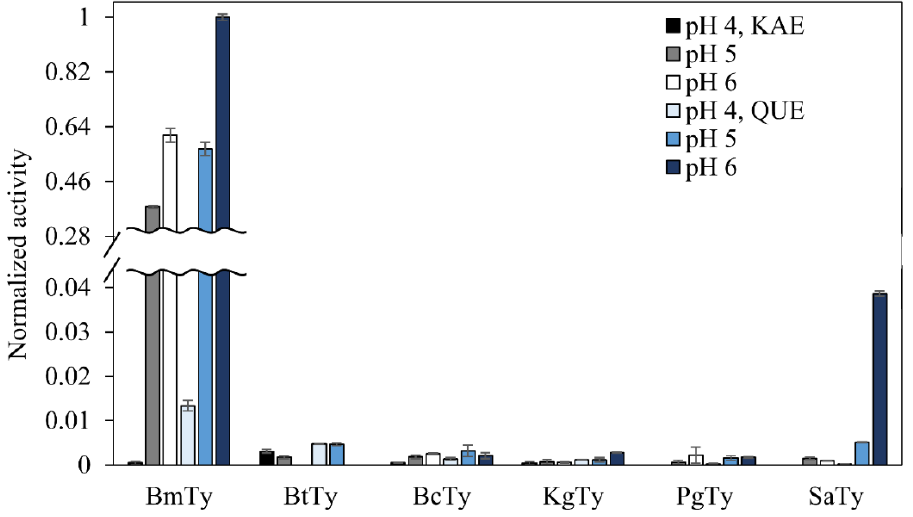
Figure 3. MBTH activity assay for six microbial tyrosinases against kaempferol and quercetin. Each purified tyrosinase (0.5 μM) was measured for its oxidation (or quinone formation) activity against 500 μM of substrates under mild acidic conditions.